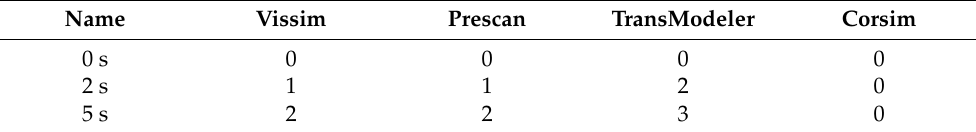
Table 7. The number of vehicles passing through the intersection with different simulation software.